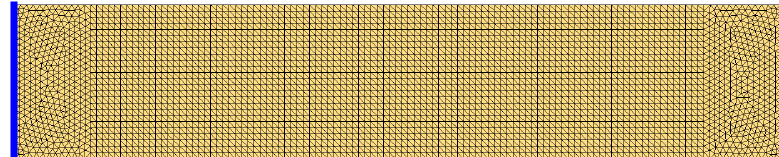
Figure 4. Finite element mesh of the rectangular cavity used to simulate unidirectional injections.